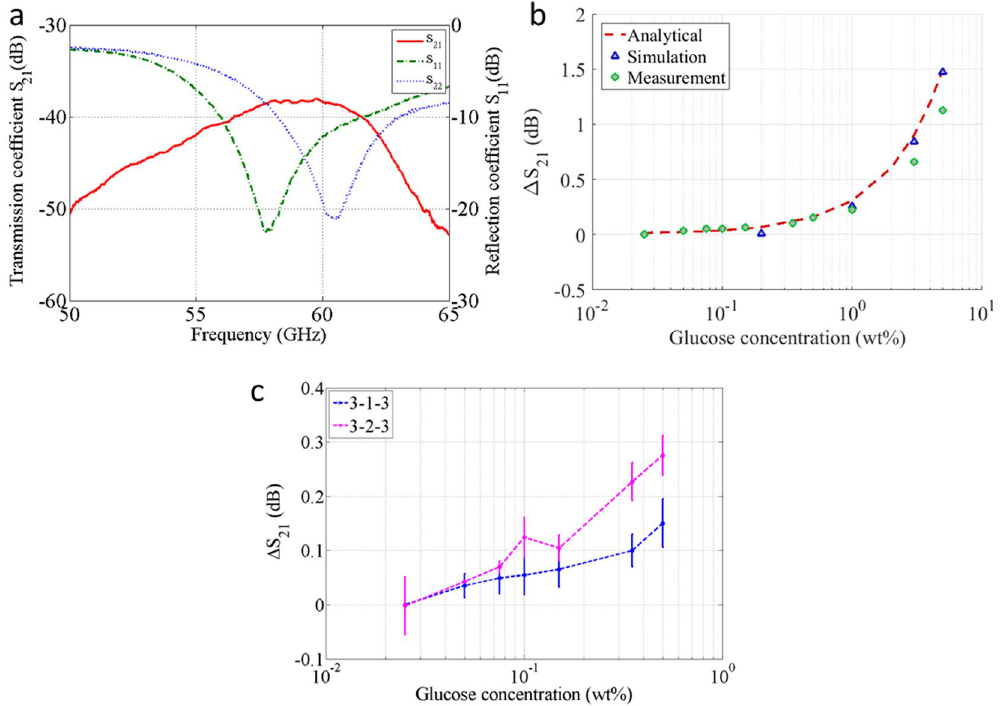
Figure 5. The correlation between transmission coeffcient and glucose concentration. ( a ) Reflection and transmission coefficient vs. frequency for a 3-1-3 tank filled with pure water ( b ) Δ S 21 for various glucose concentration from measurement, simulation and analytical calculation @ maximum trasnmission coefficient. ( c ) Δ S 21 for 0–0.5% (smaller) glucose concentration from transmisison measurement for 3-1-3 and 3-2-3 tank @ maximum trasnmission coefficient. The plot has been shifted to zero for 0.025% since pure water (0%) is not seen in log scale. X axis has been plotted in log scale for both b & c to distinguish the lower concentrations. The error bar are standard deviation from three sets of